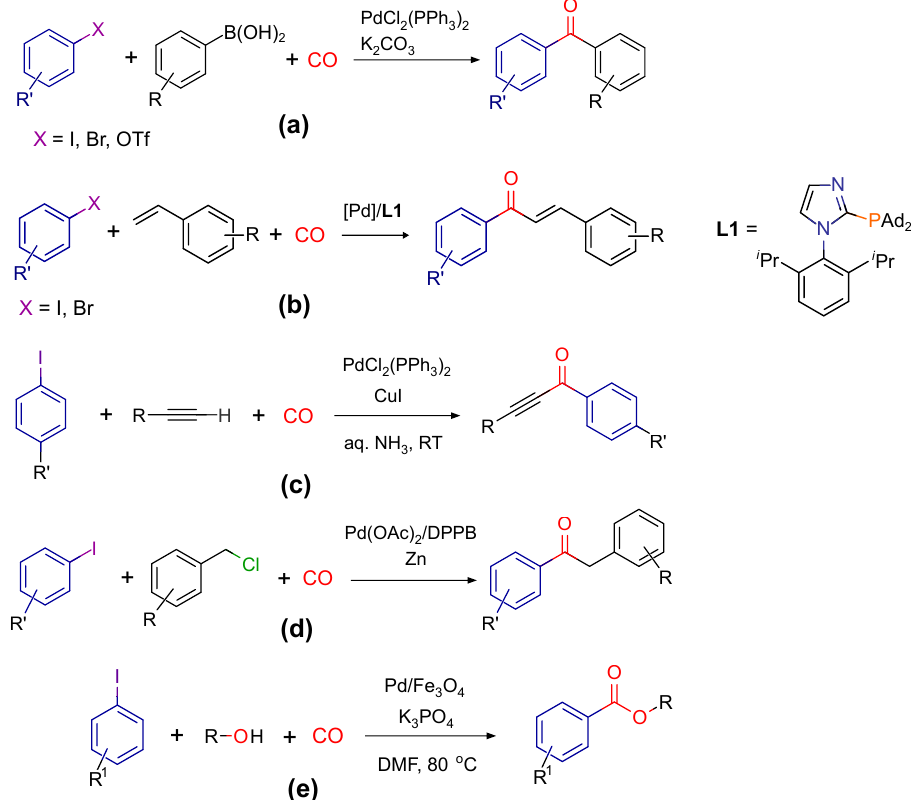
Figure 1. Carbonylative cross-coupling reactions: Carbonylative Suzuki-Miyaura [7] ( a ), Heck [8] ( b ), Sonogashira [9] ( c ), Negishi [10] ( d ) reactions, and the alkoxycarbonylation of aryl iododes [15] ( e ).